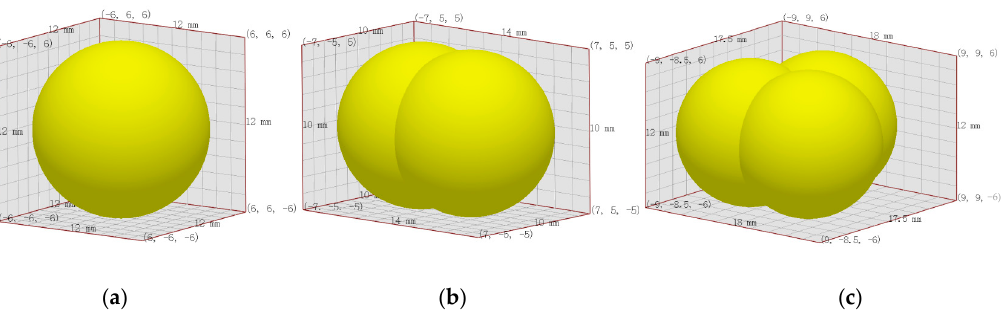
Figure 7. Soil particle template. ( a ) radius of 6 mm; ( b ) radius of 8 mm; ( c ) radius of 9 mm.